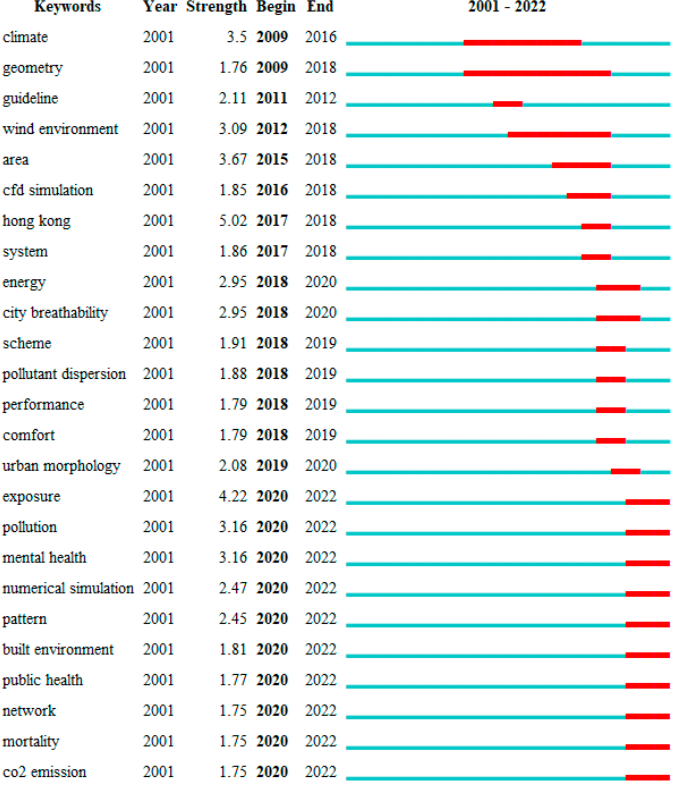
Figure 13. Top 25 keywords with the strongest citation bursts during 2001–2022.